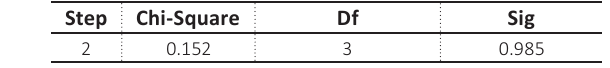
Table 5. Hosmer and Lemeshow test